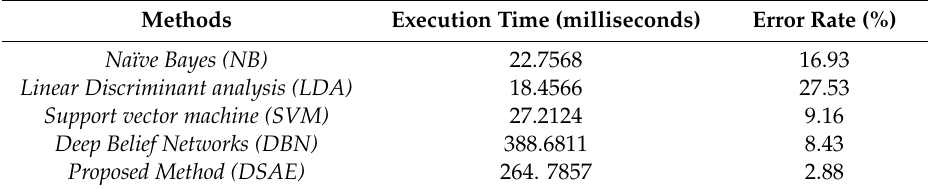
Table 7. Computational time of each